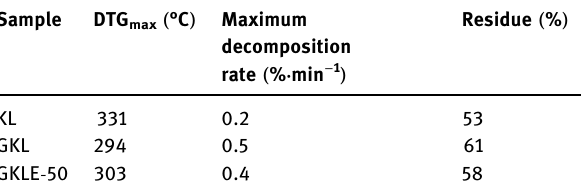
Table 2: Results from thermal analysis for DTG max , maximum decomposition rate, and residue Sample